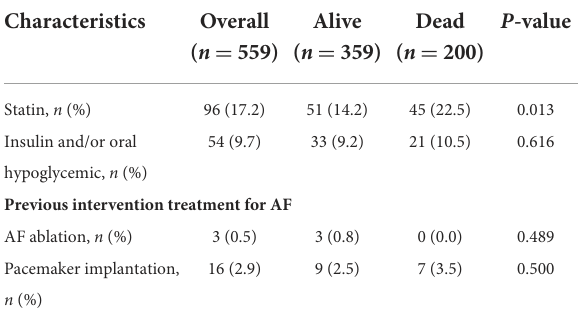
TABLE 1 Patient characteristics at baseline.